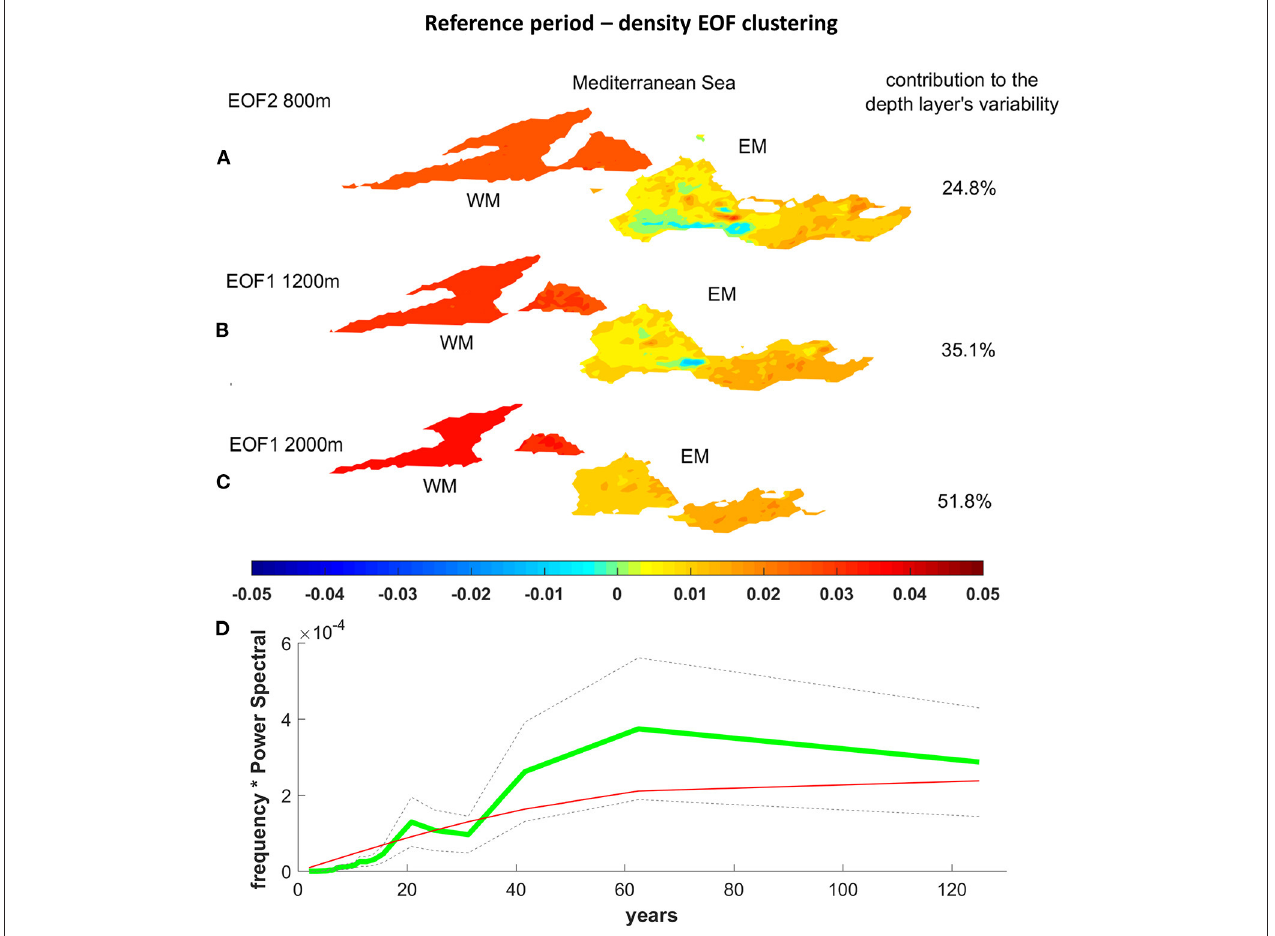
FIGURE 9 | The second EOF mode of 800m depth (A) and the first EOF modes of 1,200 and 2,000m of the current experiment (B,C) , whose expansion coefficients are well-correlated. Here the variance-preserving spectrum of the 2,000m first EOF is presented (green line), along with its 95% confidence intervals (dashed gray lines) and the normalized red noise (red line) (D)